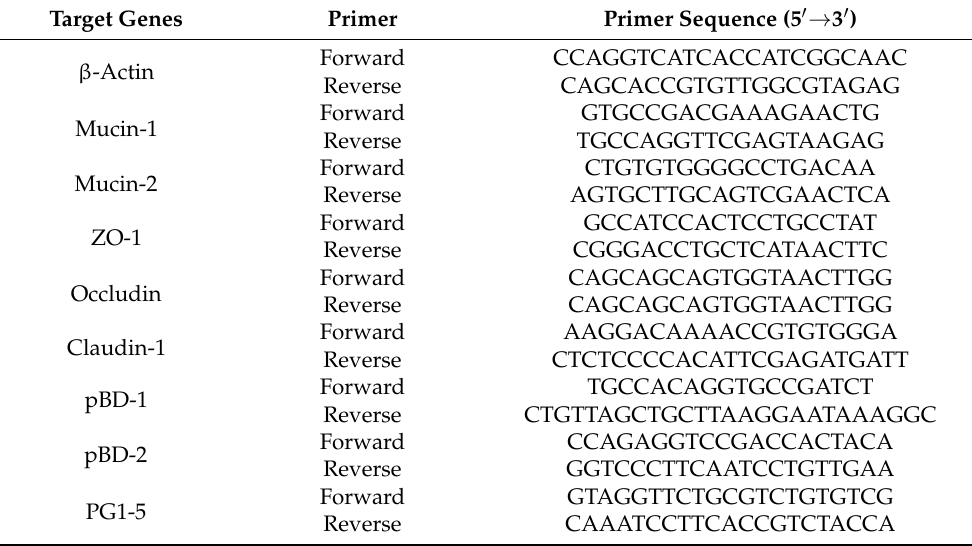
Table 2. Primer sequences for real-time